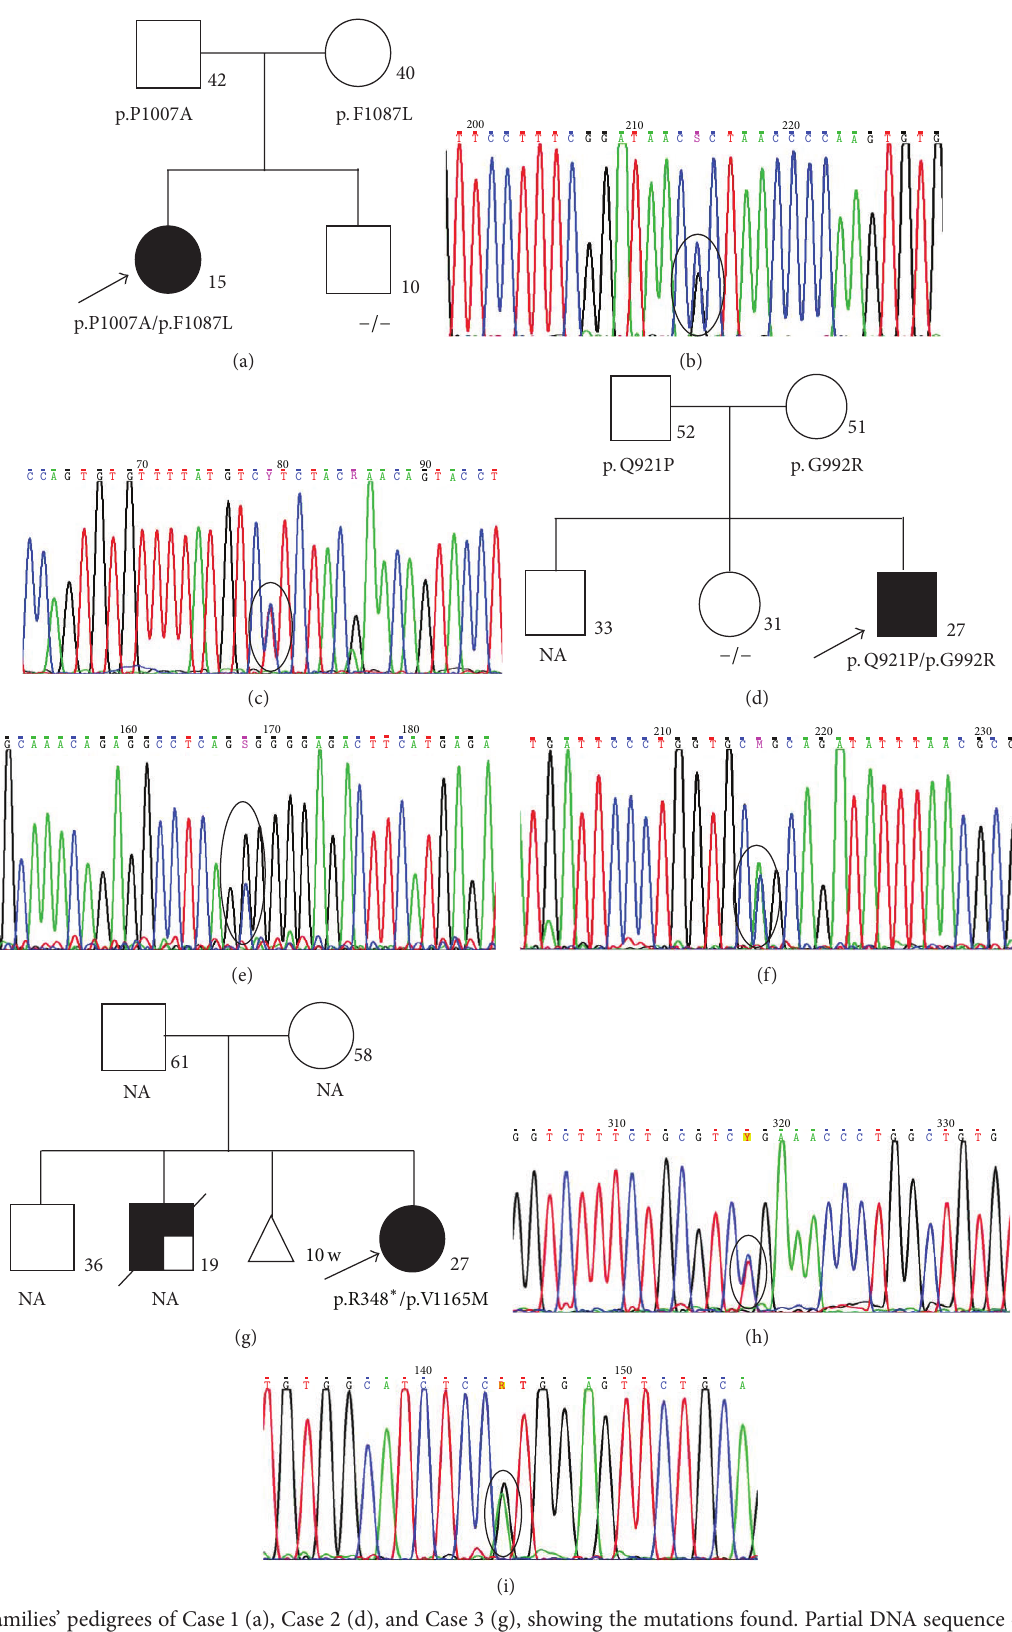
Figure 2: Families’ pedigrees of Case 1 (a), Case 2 (d), and Case 3 (g), showing the mutations found. Partial DNA sequence of NPC1 gene of Case 1 showing the p.P1007A mutation in exon 20 (b) and p.F1087L mutation in exon 22 (c). Partial DNA sequence of NPC1 gene of Case 2 demonstrating p.Q921P mutation in exon 18 (e) and p.G992R mutation in exon 20 (f). Partial DNA sequence of NPC1 gene of Case 3 demonstrating p.R348 ∗ in exon 8 (h) and p.V1165M in exon 23 (i). NA: not